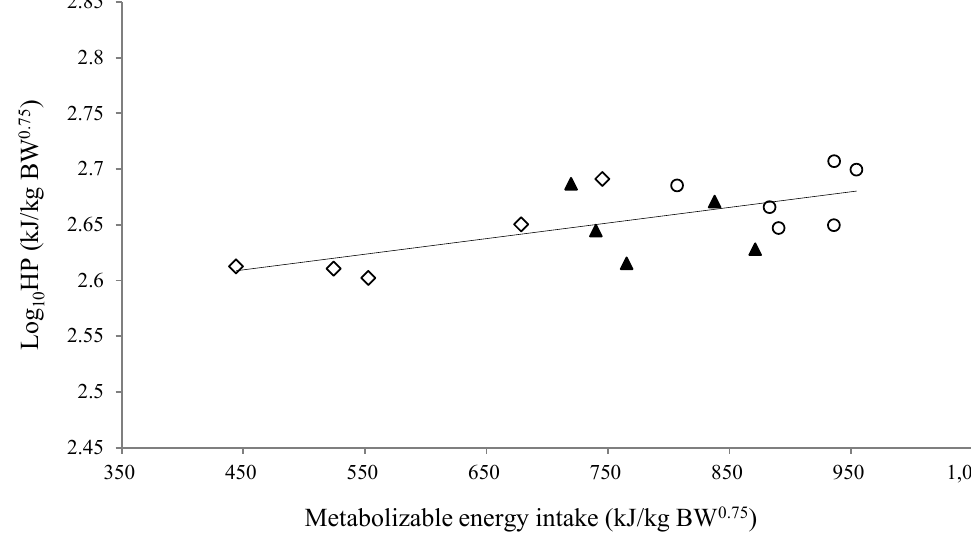
Figure 2. Linear regression of the logarithm of heat production (Log HP, kJ/kg BW 0.75 ) against metabolizable energy intake (MEI, kJ/kg BW 0.75 ) of yearling Thai native beef cattle fed fermented total mixed ration diets with different proportions [100 (◊), 300 ( ▲ ), and 500 ( ○ ) g/kg dry matter basis] of cassava pulp instead of rice straw. Equation: Log HP = (0.00015 ×MEI)–2.53 (r 2 = 0.51; p<0.001; residual standard deviation = 0.007).